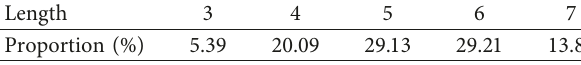
Figure 2: Principle diagram of 5-Gram segmentation. Table 1: Each level substring length proportion.